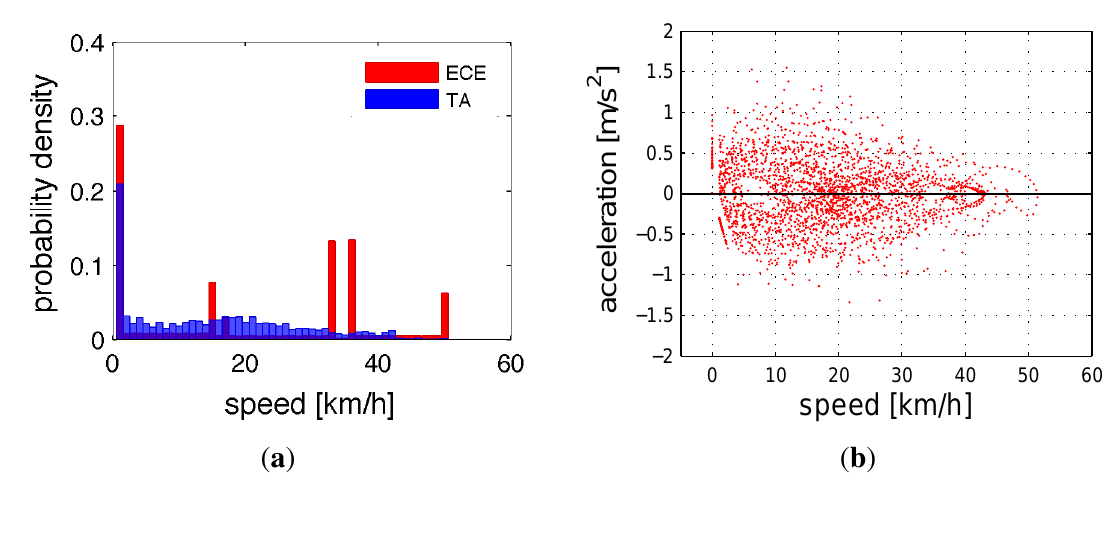
Table 1. Vehicle characteristics and other